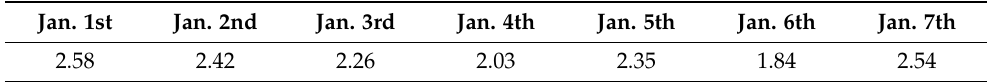
Table 3. H 2 (m) during